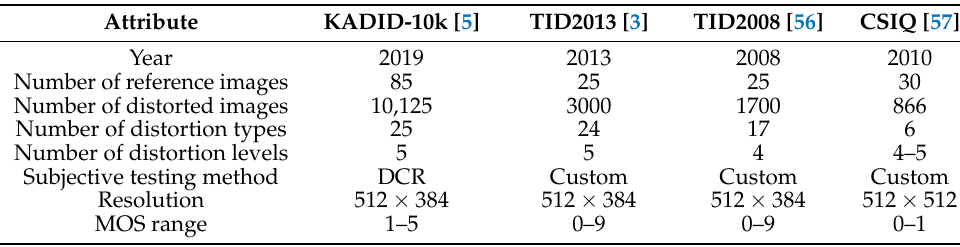
Table 1. Summary about the main properties of the applied publicly available IQA benchmark databases.